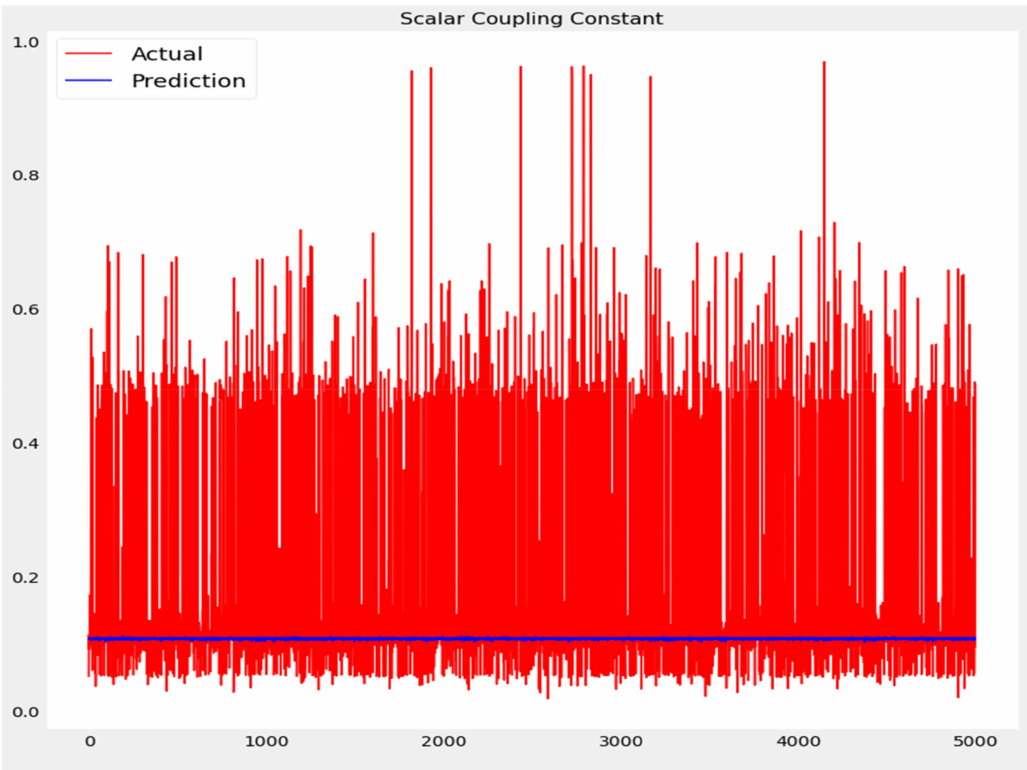
Figure 13. Actual and prediction values of